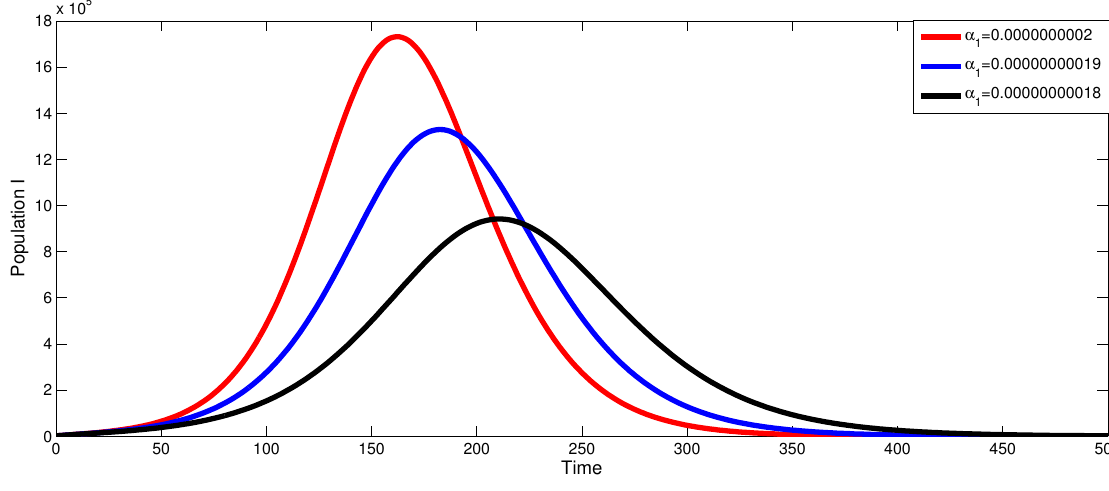
Fig. 4. Time series of the infected population with α 2 = 1 × 10 − 10 for different values of α 1 and other input values taken from Table 1 and